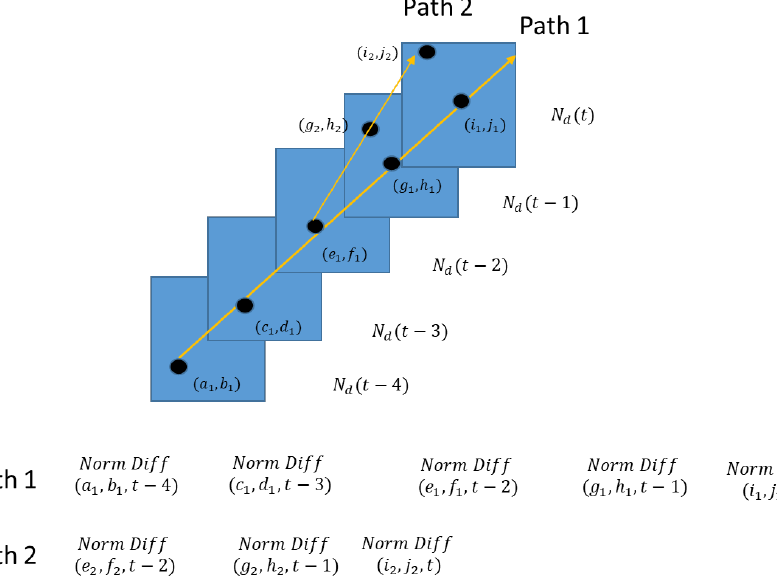
Figure 5. Motion Path Creation Illustration. Note, in this example, our approach adds a delay to the overall processing by two frames.